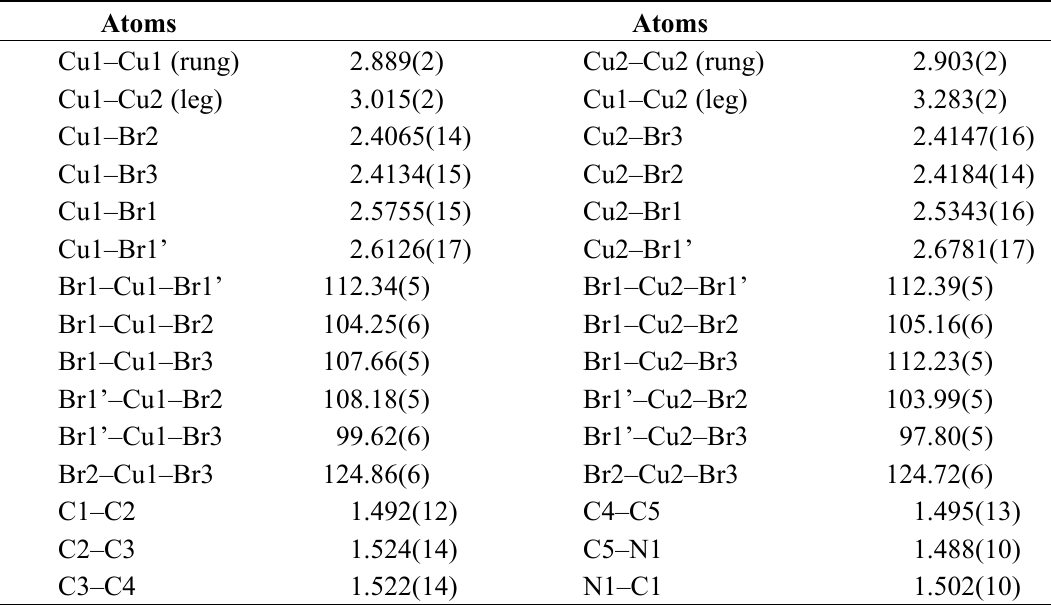
Table 3. Atomic distances/Å and angles/° at 173 K.